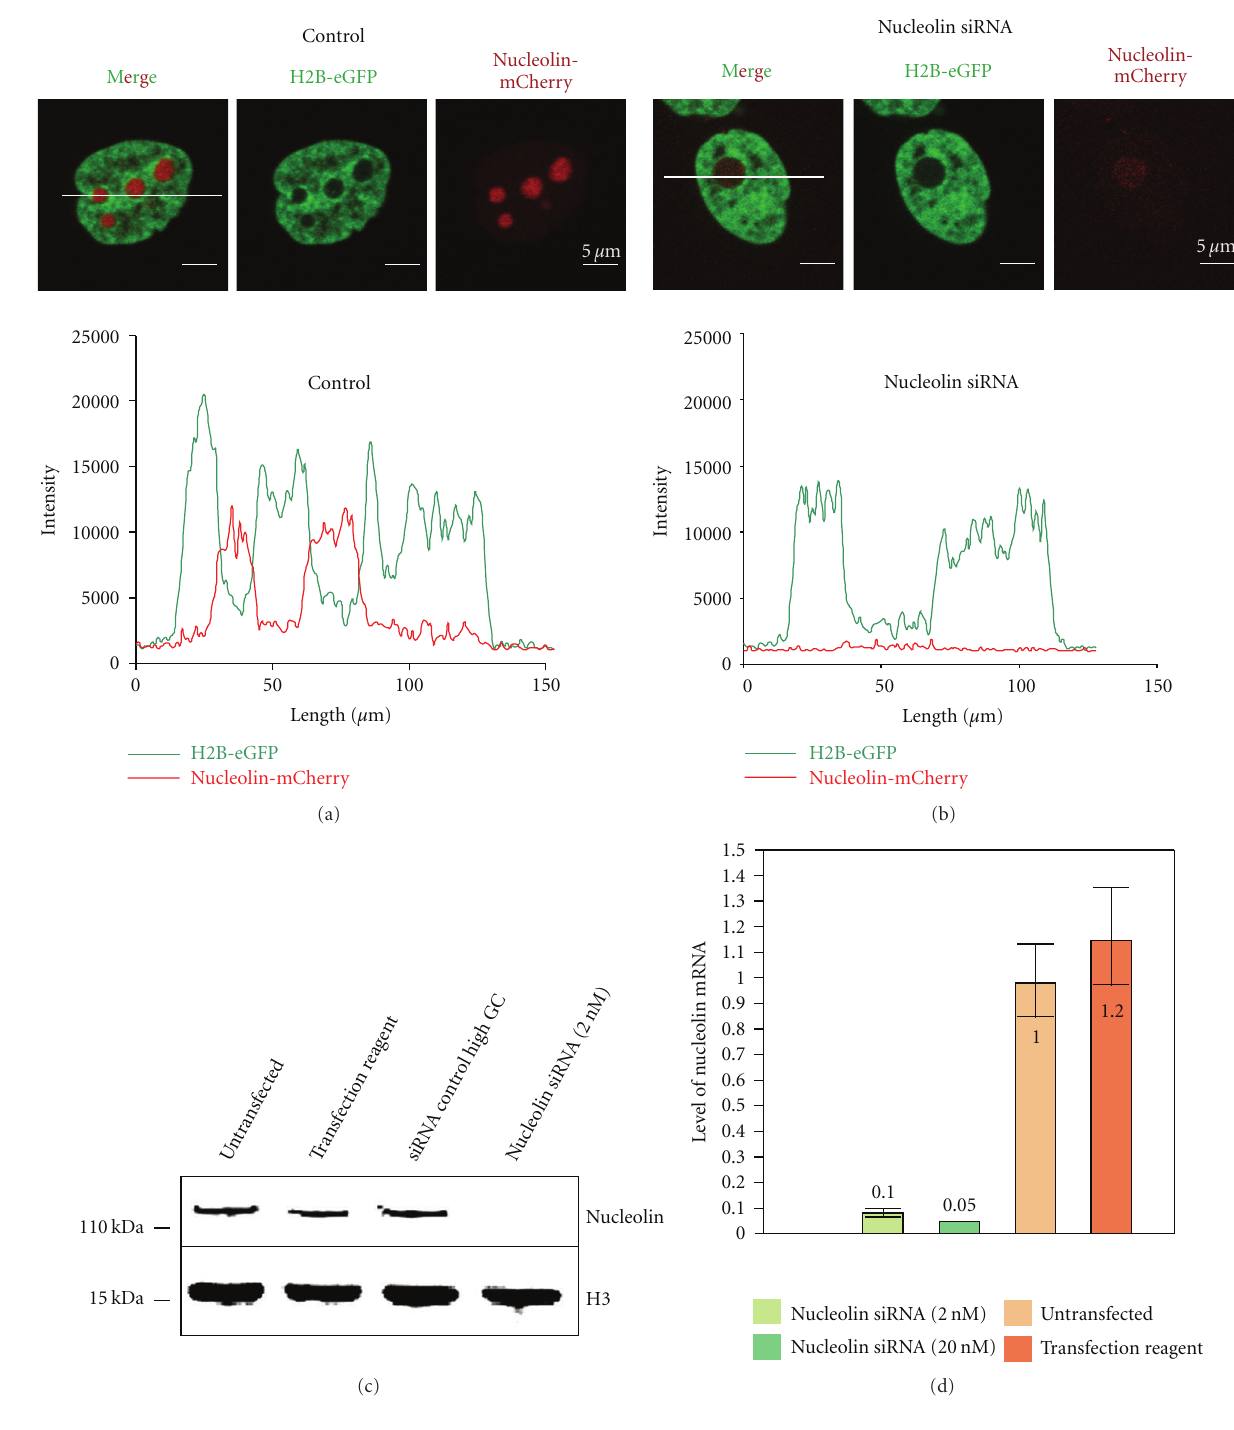
Figure 1: siRNA-mediated down-regulation of nucleolin. (a)-(b) Confocal section of live HeLa cells stably expressing nucleolin-mCherry (red) and the histone H2B-eGFP (green) visualized before (a) or after nucleolin silencing (b). Scale bars represent 5 μ m. H2B-eGFP and nucleolin-mCherry fluorescence intensity along the white lines are presented under the fluorescent images. (c) Western blot analysis of nucleolin in nonfluorescent HeLa cells: untransfected control cells, control cells transfected only with the transfection reagent, cells transfected with siRNA control high GC and siRNA against nucleolin-treated cells (mix siRNA #2 and #4 at 2nM). Equal loading was verified using antihistone H3 antibody. (d) Quantitative RT-PCR analysis of nucleolin mRNA in nonfluorescent HeLa cells: untransfected control cells, control cells transfected only with the transfection reagent, siRNA against nucleolin-treated cells (mix siRNA #2 and #4 at 2nM) and siRNA against nucleolin treated cells (mix siRNA #2 and #4 at 20nM). Data were normalized with the amount of β -actin mRNA and the amount of mRNA in control